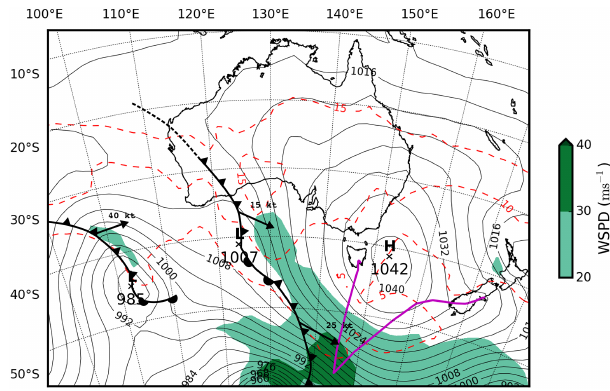
Figure 1. ERA-Interim mean sea level pressure at 00:00UTC on 29 June 2011, with synoptic features as analyzed by the Australian Bureau of Meteorology, 950hPa wind speed (colors; ms − 1 ), and 950hPa temperatures (dashed red contours at 5, 10, and 15 ◦ C). The flight track for HIPPO-4 RF06 is shown in